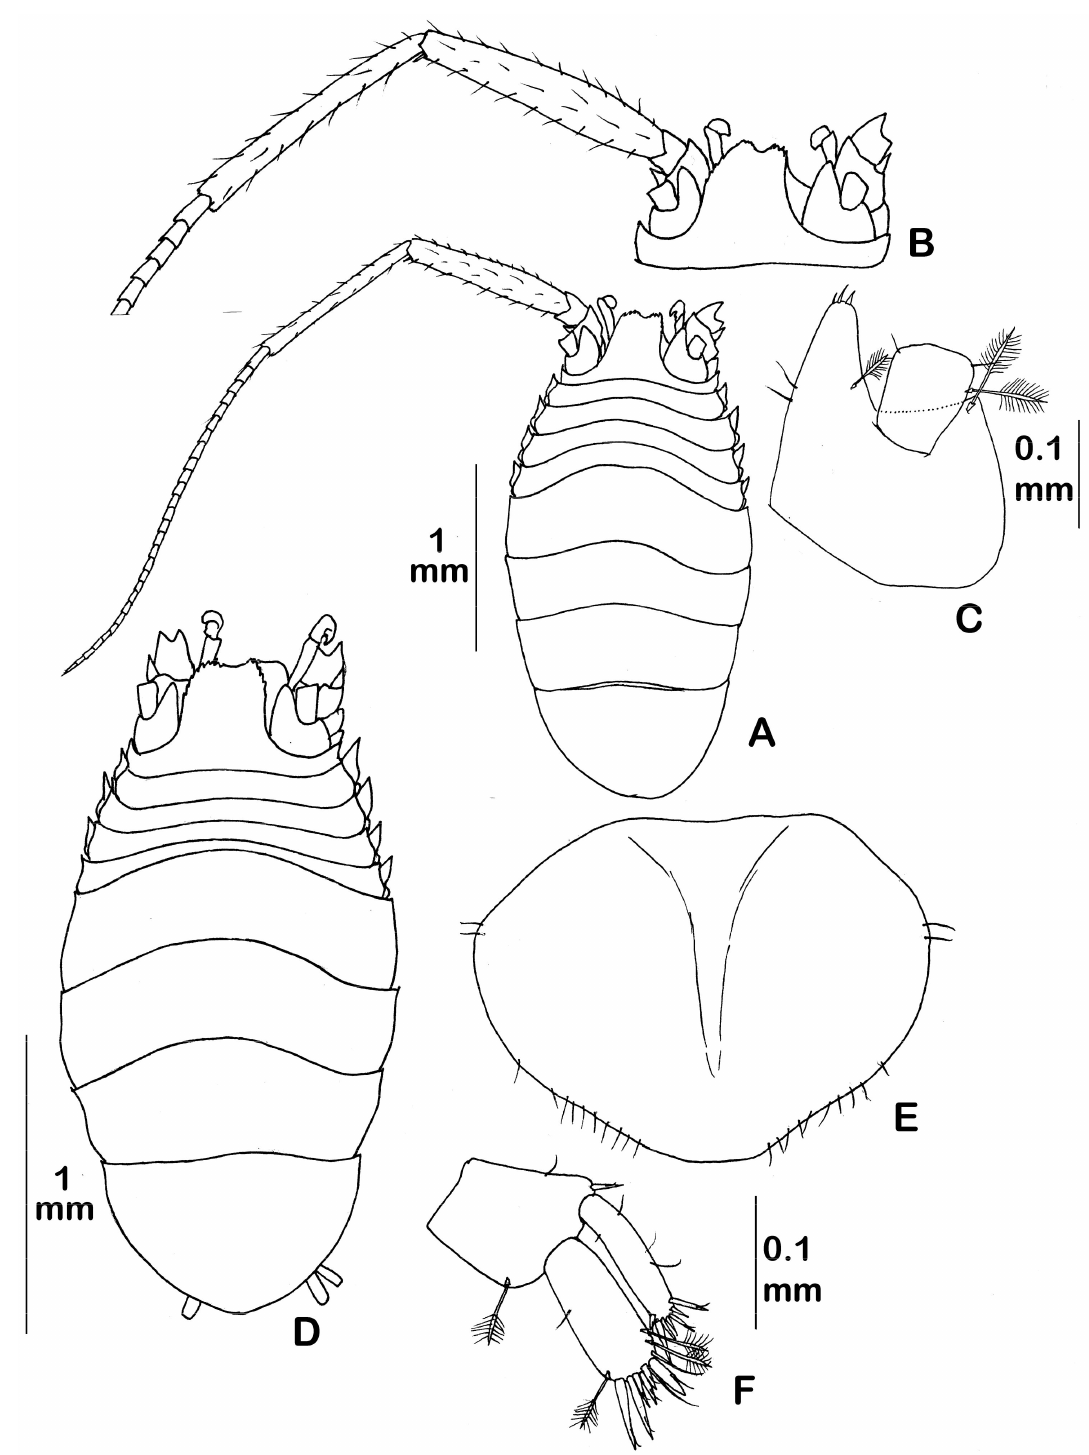
Figure 33. Eurycope jakobi sp. nov. Female paratype (ZMH K-45657): ( A ) dorsal view; ( B ) cephalon with rostrum, basal parts of antennae I and antenna II; ( C ) antenna I. Female paratype (ZMH K-45658): ( D ) dorsal view; ( E ) pleopod II; ( F ) uropod. Mandible (female paratype, ZMH K-45658, Figure 34A,B) incisor with four and three cusps and spine row with nine and eight spines on right and left mandibles, respectively; lacinia mobilis of left mandible visibly shorter than incisor, with three distal teeth; molar process distodorsally acute, with four thin setae on base of denticles.